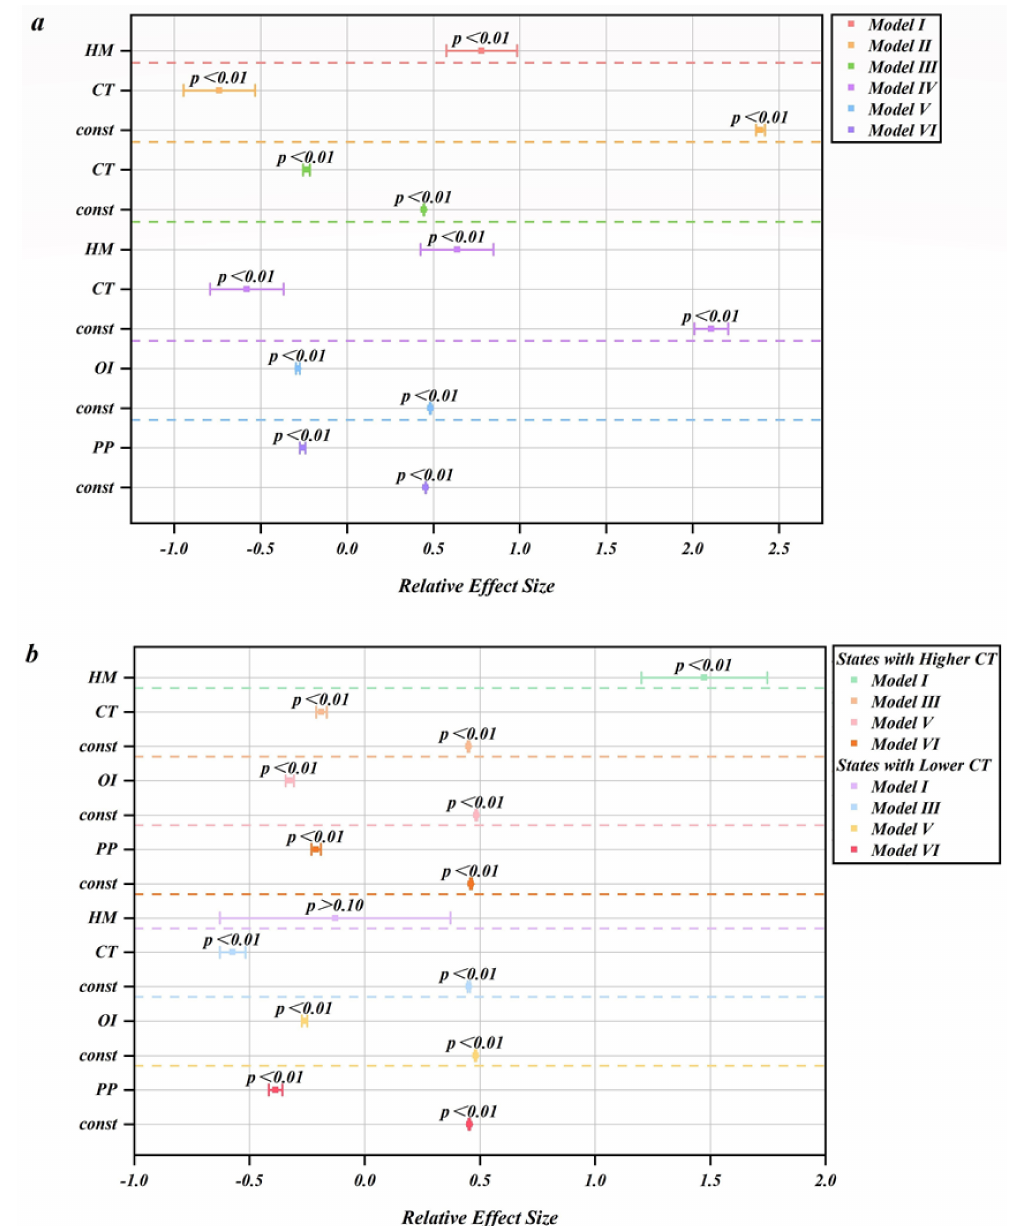
Figure 2. ( a ) Based on the national level dataset, line 1 to 6 display the empirical results of our mediation analysis, i.e., Models I to VI. ( b ) Displays the results of the empirical estimation (Models III, I, V and VI) using the dataset of the classified states (see Table